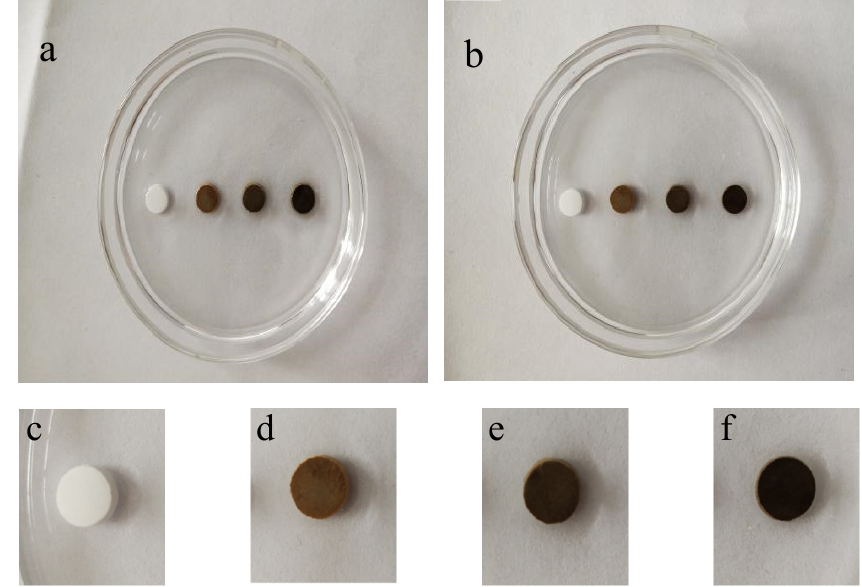
Figure 4. Anti-washout property of Fe-doped cement samples before ( a ) and after ( b ) immersing for 60 min in SBF solution (from left to right are Fe-0, Fe-2.5, Fe-5 and Fe-10); and ( c – f ) enlarged pictures of samples after immersing for 60 min, respectively.